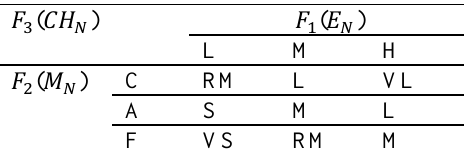
Figure 3 . Member functions of each parameter.